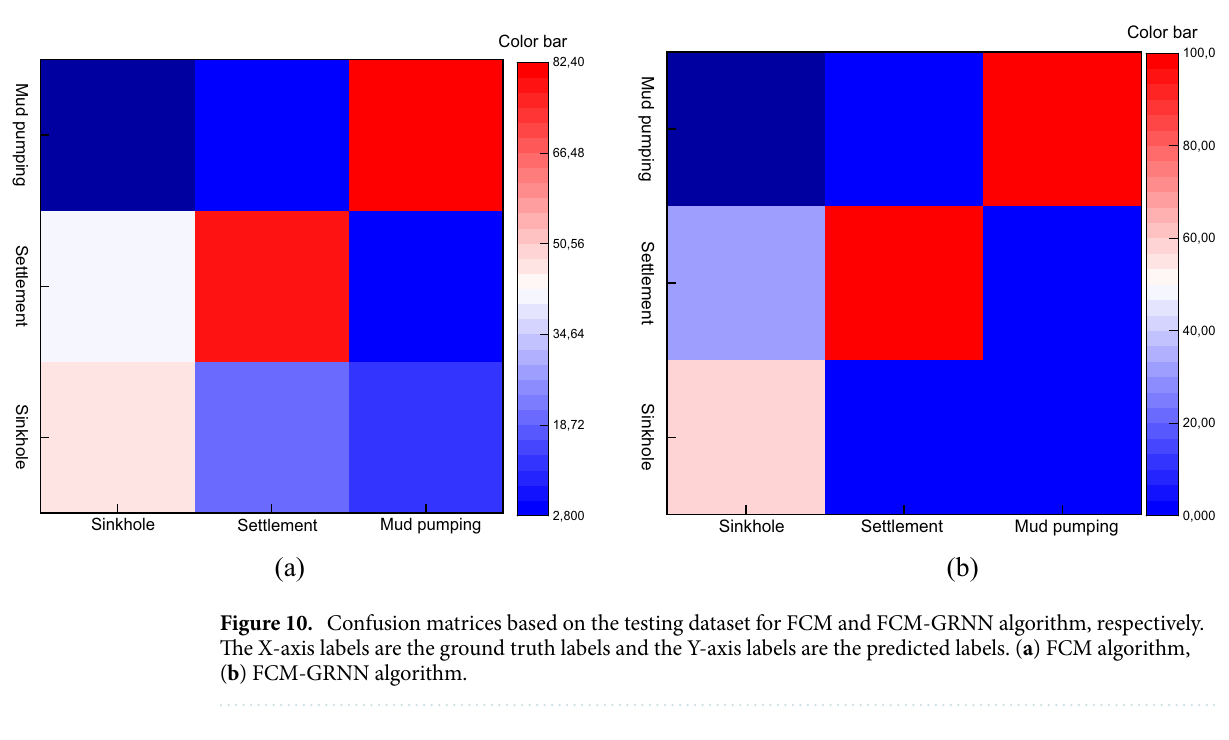
Figure 9. Effect of training epoch on FCM-GRNN test performance.